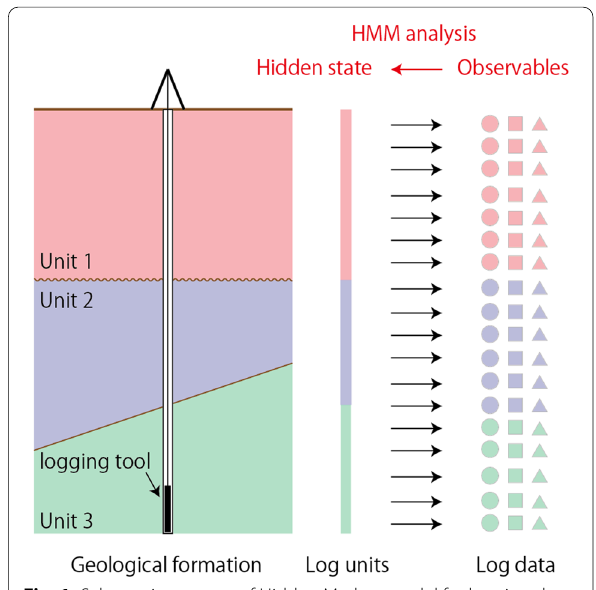
Fig. 1 Schematic concept of Hidden Markov model for logging data